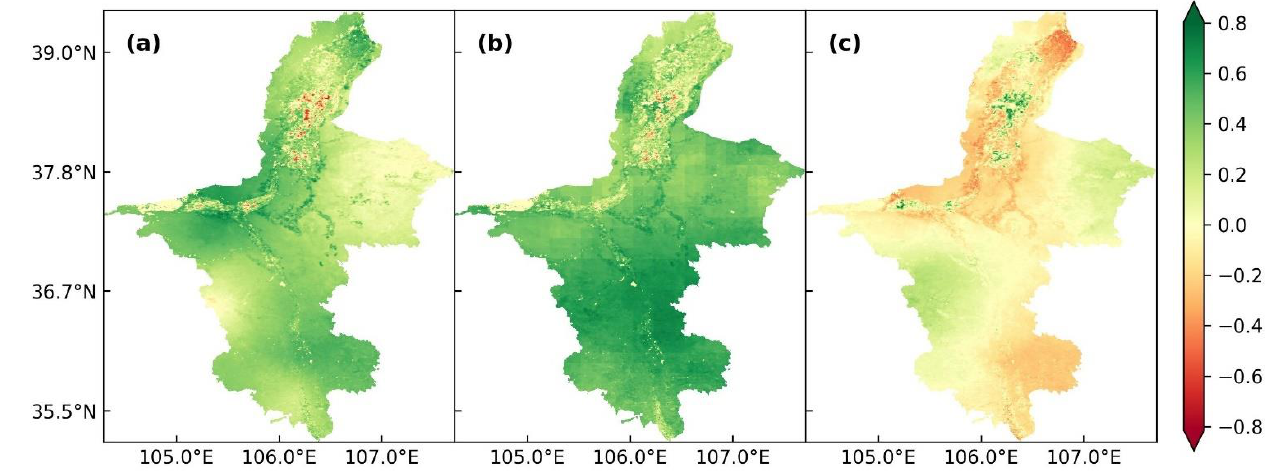
Figure 8. Analysis of the spatial distribution of the correlation between ET and three meteorological factors in Ningxia from 2001 to 2020. ( a – c ) Spatial distribution of the correlation between ET and surface temperature ( a ), precipitation ( b ) and relative humidity ( c ).